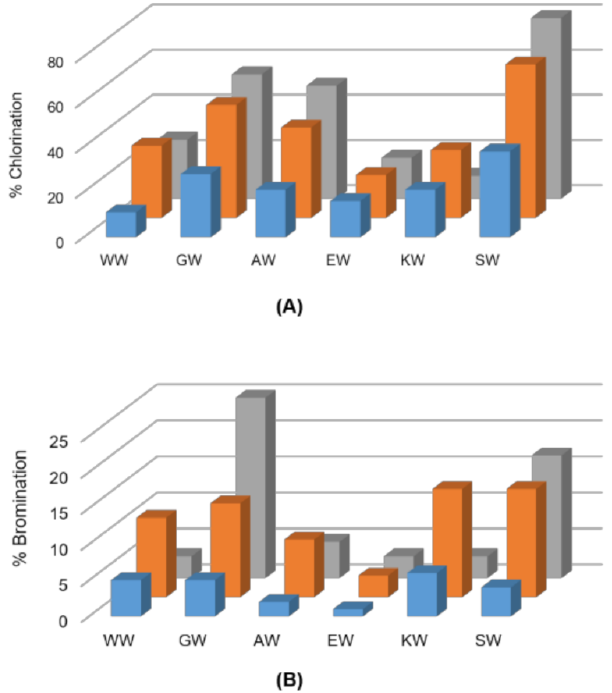
Figure 1. Screen for ( A ) chlorination and ( B ) bromination of indicated dipeptides using ThHal (blue), SttH (orange) and PyrH (grey)